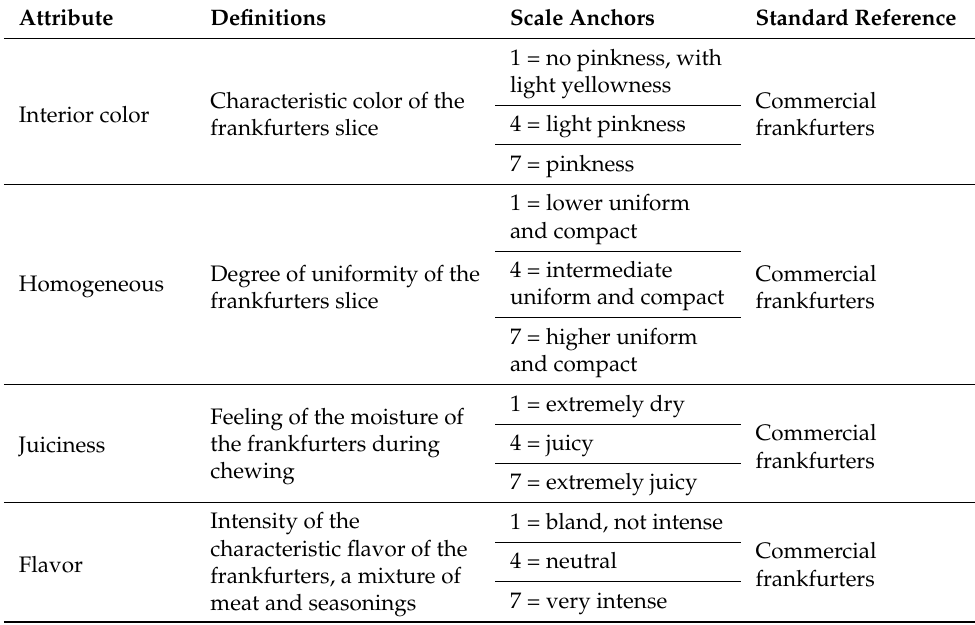
Table 3. Attributes, definitions, scale anchors and standard references used in descriptive sensory analysis of frankfurters with different formulas. Definitions Standard